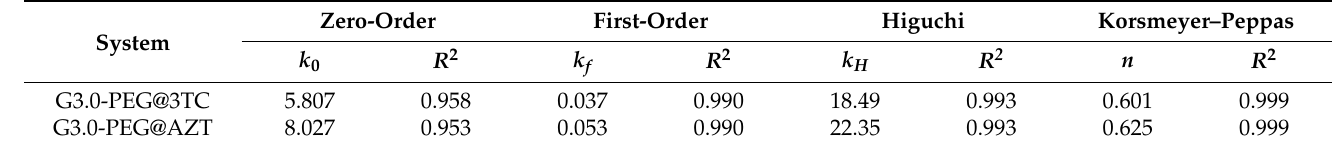
Figure 6. Release profile of free and loaded 3TC ( a ) and AZT ( b ) in 4 different pH conditions. Empty circle: free drugs at pH 7.4; Solid circle: loaded drugs at pH 1.2; Solid square: loaded drug at pH 4.5; Solid triangle: loaded drugs at pH 6.8; Solid diamond: loaded drugs at pH 7.4. Table 3. Rate constants and correlation coefficients of ARV@G3.0@mPEG systems in pH = 7.4 condition obtained through some mathematic